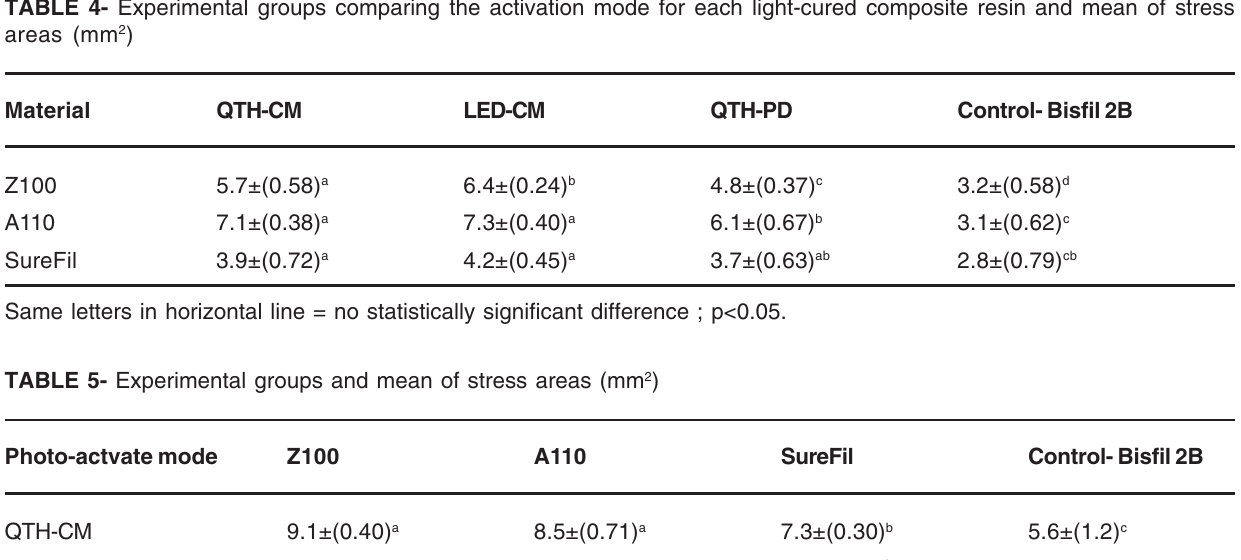
Same letters = no statistically significant difference; p<0.05. TABLE 4- Experimental groups comparing the activation mode for each light-cured composite resin and mean of stress areas (mm 2 )